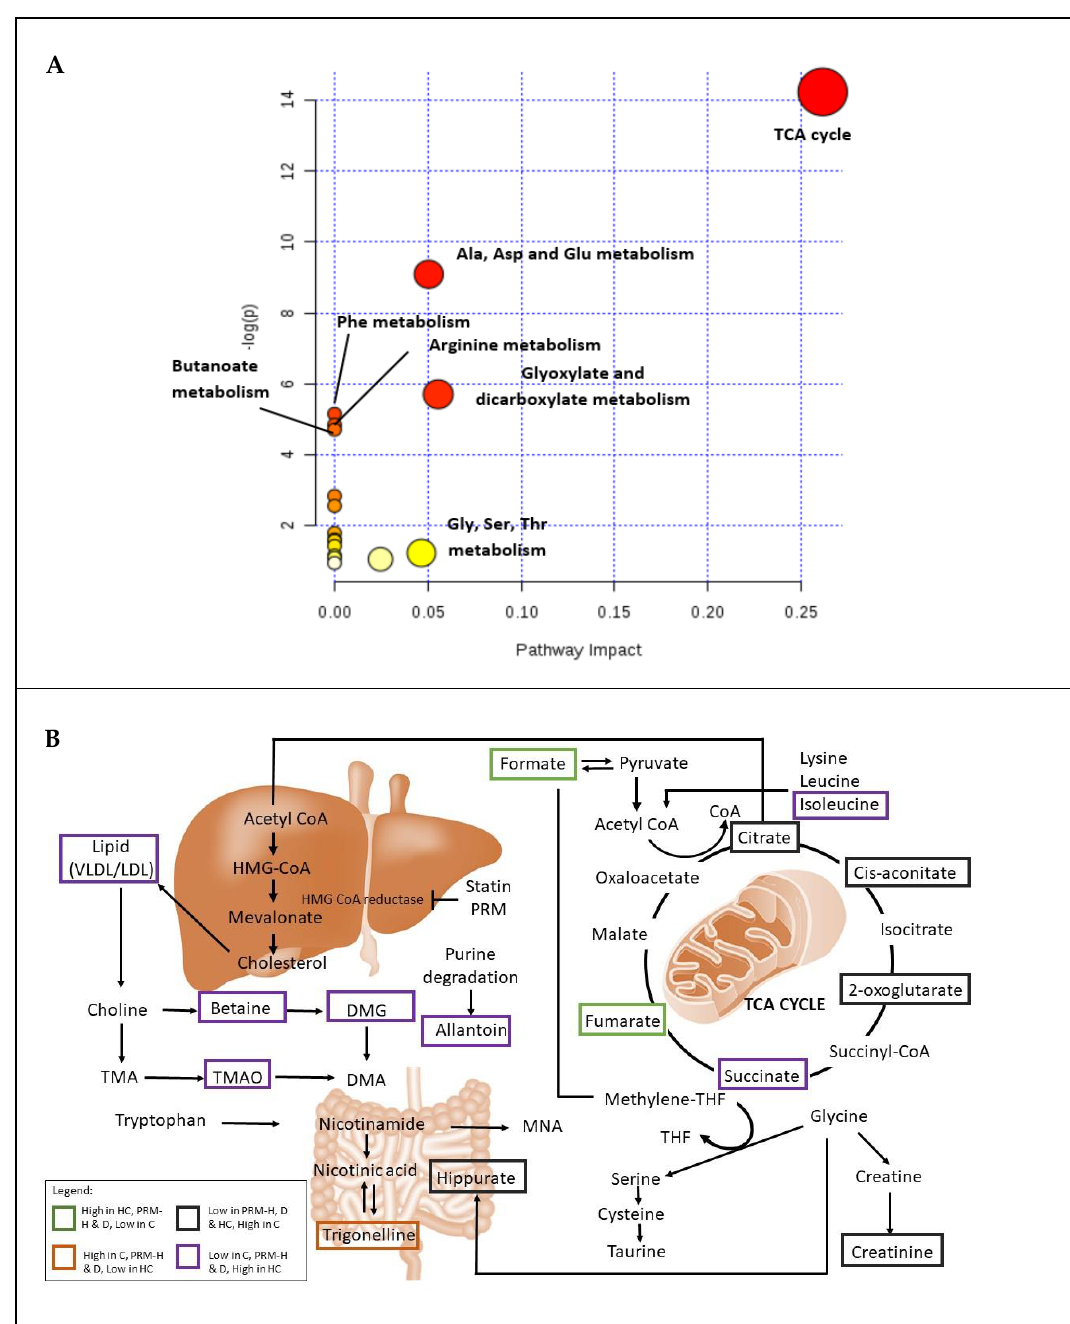
Figure 3. Illustrated pathways involved. ( A ) Summary from MetaboAnalyst 4.0 pathway analysis. The color and the size of the nodes represent the pathway ’ s degree of importance, whereas the large red notes represent the highest level of change in rats treated with PRM. Moderate, slight and zero importance is represented by the colors orange, yellow and white. The X-axis in the pathway analysis represents the hits number of metabolites in each pathway, while the Y-axis represents the number of -log (p) of the metabolites. ( B ) Tentative disturbed metabolism and pathways in Control (C), hyperlipidemia (HC), polyphenol-rich mixture high dose (PRM-H) and simvastatin (D). TMA: Trimethylamine; TMAO: Trimethylamine-N-oxide; HMG CoA: Hydroxymethylglutaryl-CoA; DMG: Dimethylglycine; DMA: Dimethylamine and THF: Tetrahydrofolate.